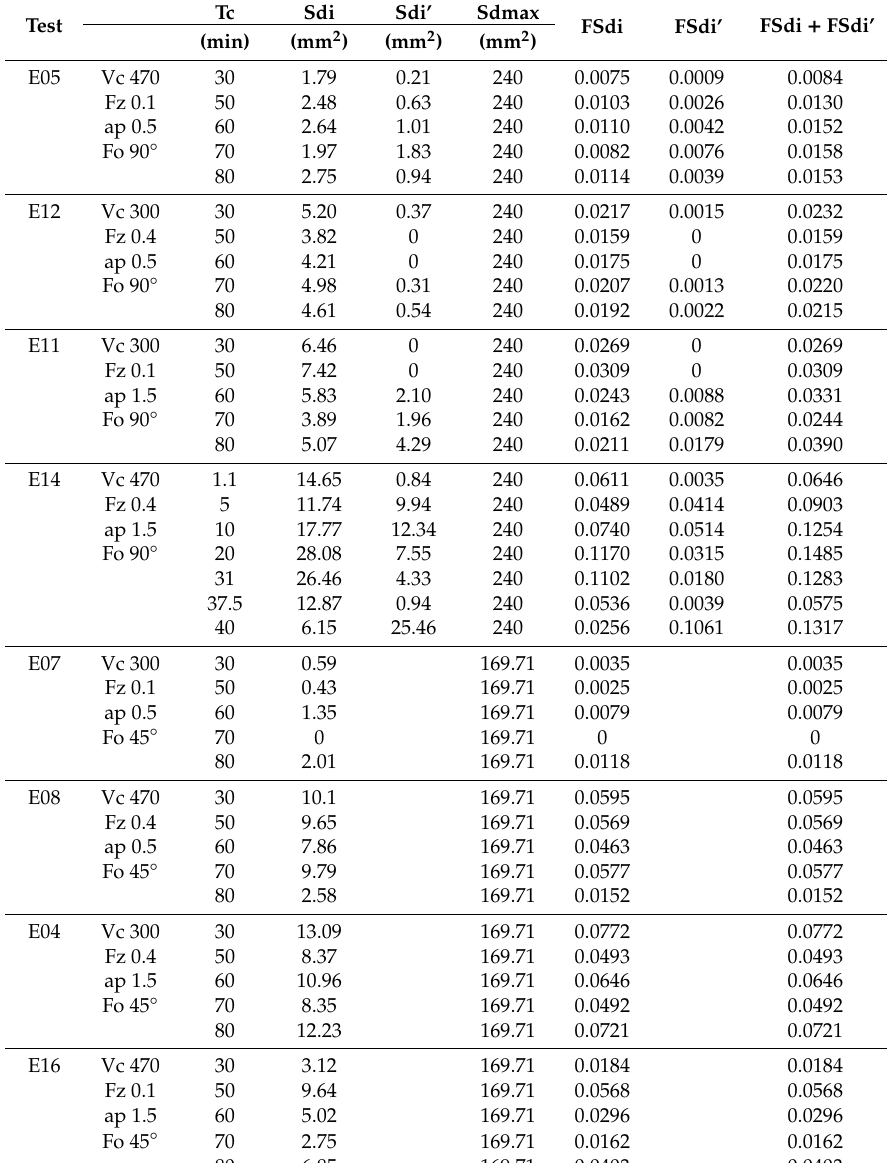
Table 8. Area parameters in Type I